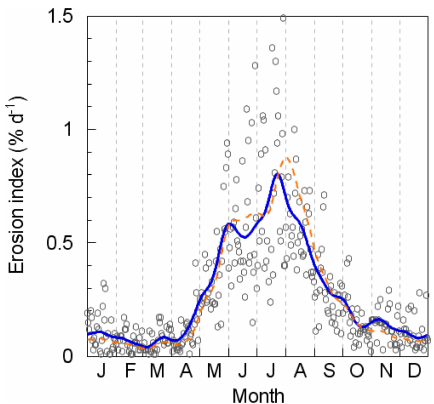
Figure 5. Measured (circles) and smoothed (solid blue line) daily erosion index derived from radar data. The daily erosion index cal- culated from measurements between 2001 and 2016 at 115 rain gauges distributed throughout Germany is given for comparison (dashed orange line). For C factor calculations the smoothed values can be taken from Table S2. Comparison of measured daily erosion indices separated for different regions in Germany and the respec- tive cumulative distribution curves are depicted in Fig. S5.